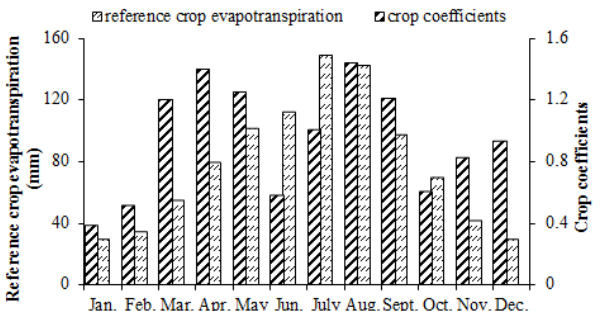
Fig. 5. Reference crop evapotranspiration and crop coefficients, de- rived from Chen